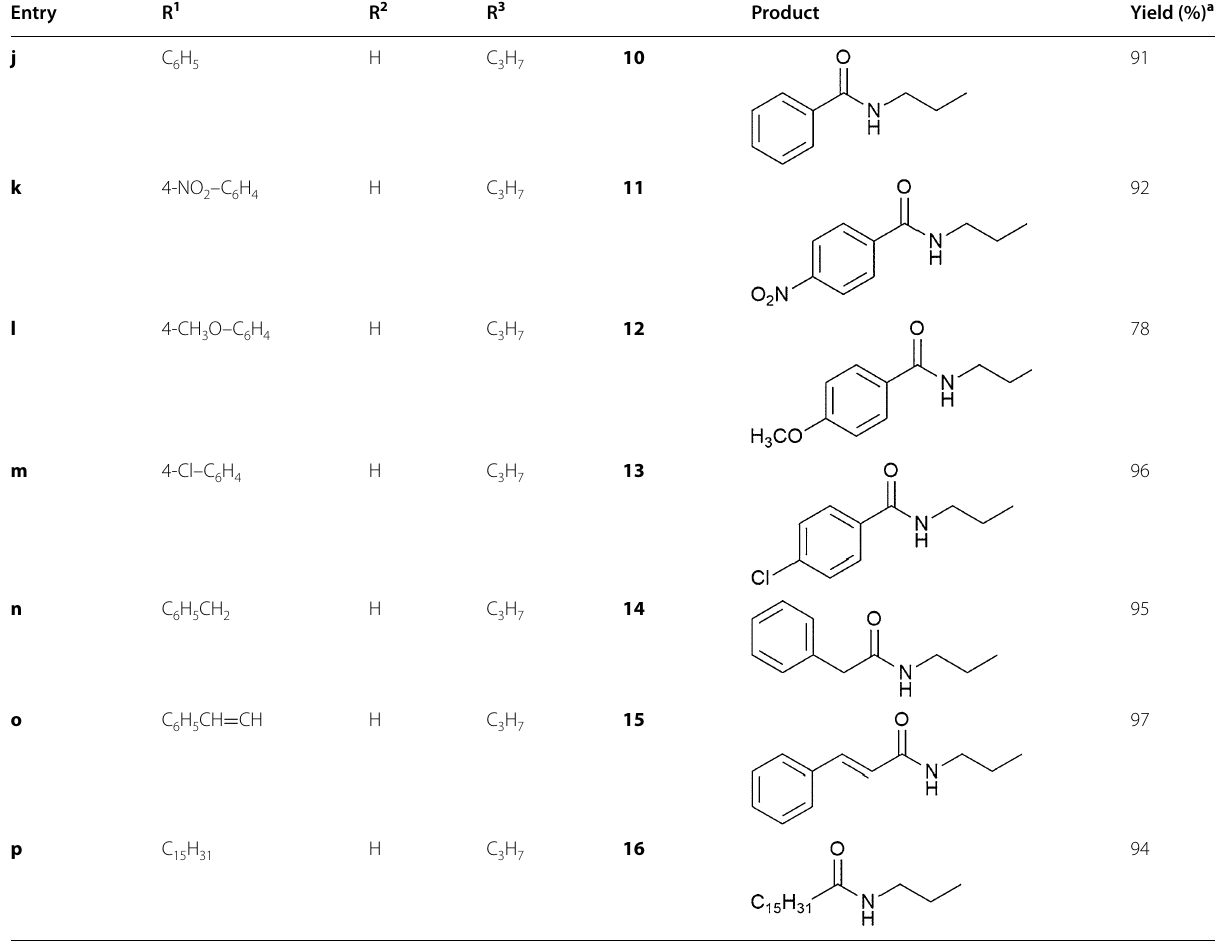
Table 3 Synthesis of N -propylamides